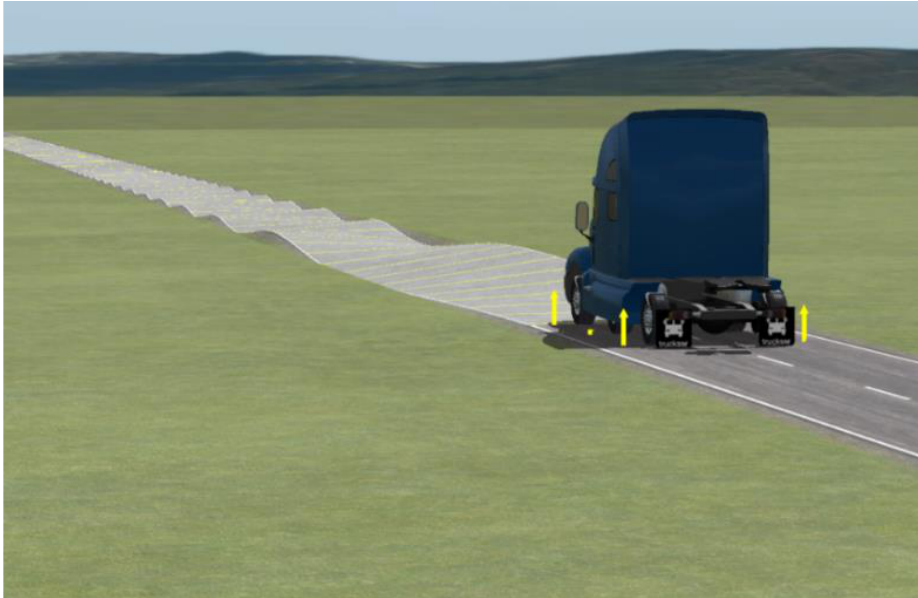
Figure 16. Sine sweep straight road. The yellow arrow represents the force on the wheel in the z-axis direction.